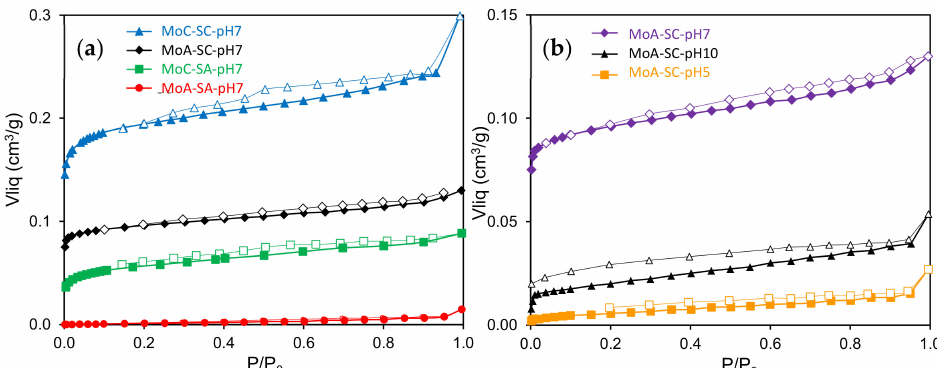
Figure 4. N 2 -adsorption isotherms showing the influence of ( a ) a combination of cationic and anionic surfactant and metal precursors and ( b ) the pH value of the starting polymerization